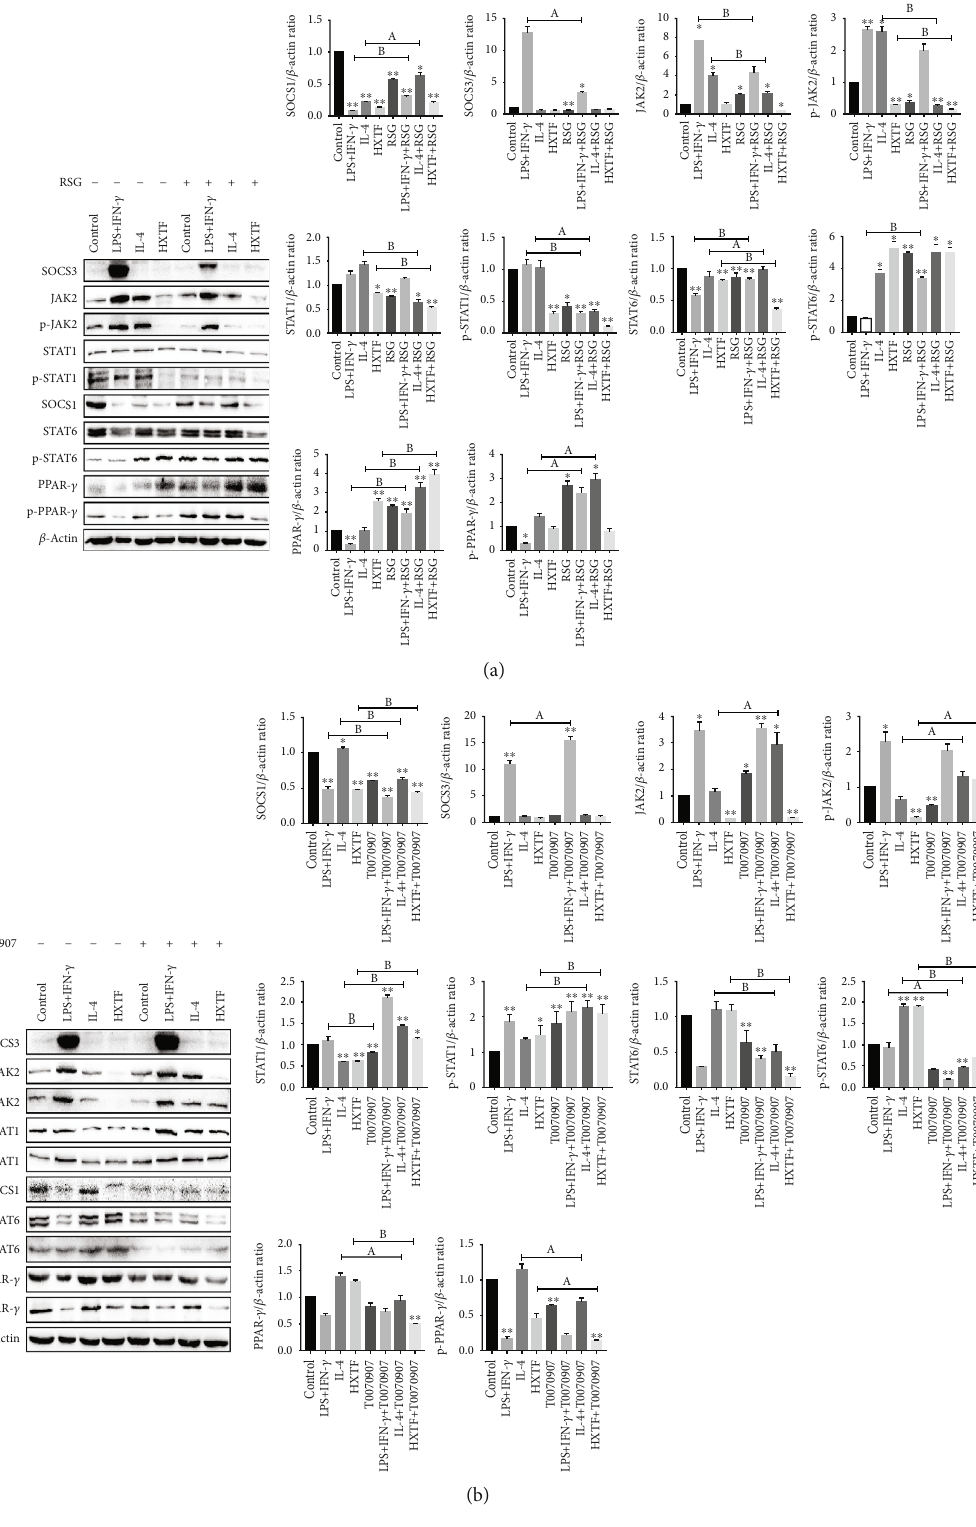
Figure 7: PPAR- γ activation on the SOCS/JAK2/STAT/PPAR- γ pathway. RAW264.7 cells were preincubated with rosiglitazone (RSG) (1 μ mol/mL) or T0070907 (1 μ mol/mL) for 3h, followed by combined treatment with either the control DMEM solution, LPS+IFN- γ , IL-4, or HuoXueTongFu Formula (HXTF) treatment for 12h. The protein expression was assayed by Western blotting. (a) RSG administration on the SOCS/JAK2/STAT/PPAR- γ pathway. (b) T0070907 administration on the SOCS/JAK2/STAT/PPAR- γ pathway. All values are expressed as mean ± S : E : ( n = 3 experiments). ∗ p < 0 : 05 , ∗∗ p < 0 : 01 , a p < 0 : 05 , and b p < 0 : 01 , comparison of the designated two